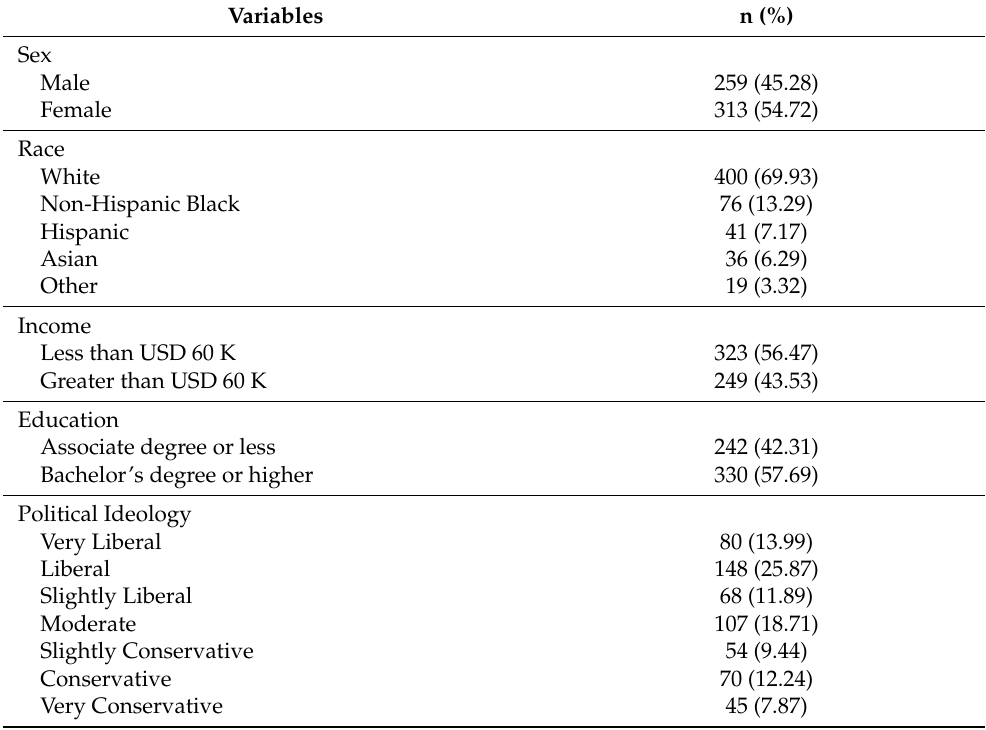
Table 1. Descriptive statistics of background factors at wave 7.